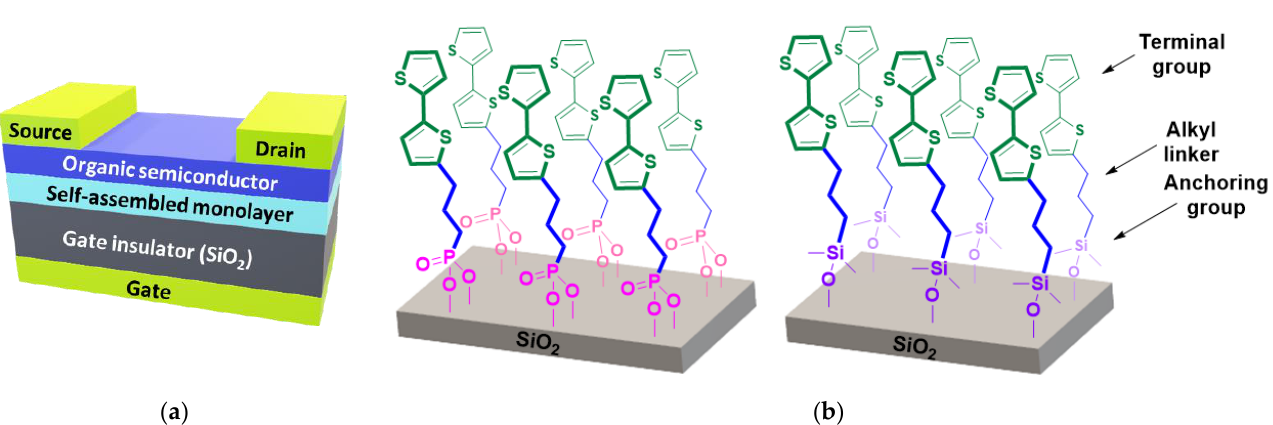
Figure 1. ( a ) Schematic view of the organic field-effect transistors (OFET) using the active layer of OS deposited on a SAM-modified gate insulator layer; ( b ) proposed modification of SiO 2 surface by SAM formation with phosphonic acid and silane anchoring group.